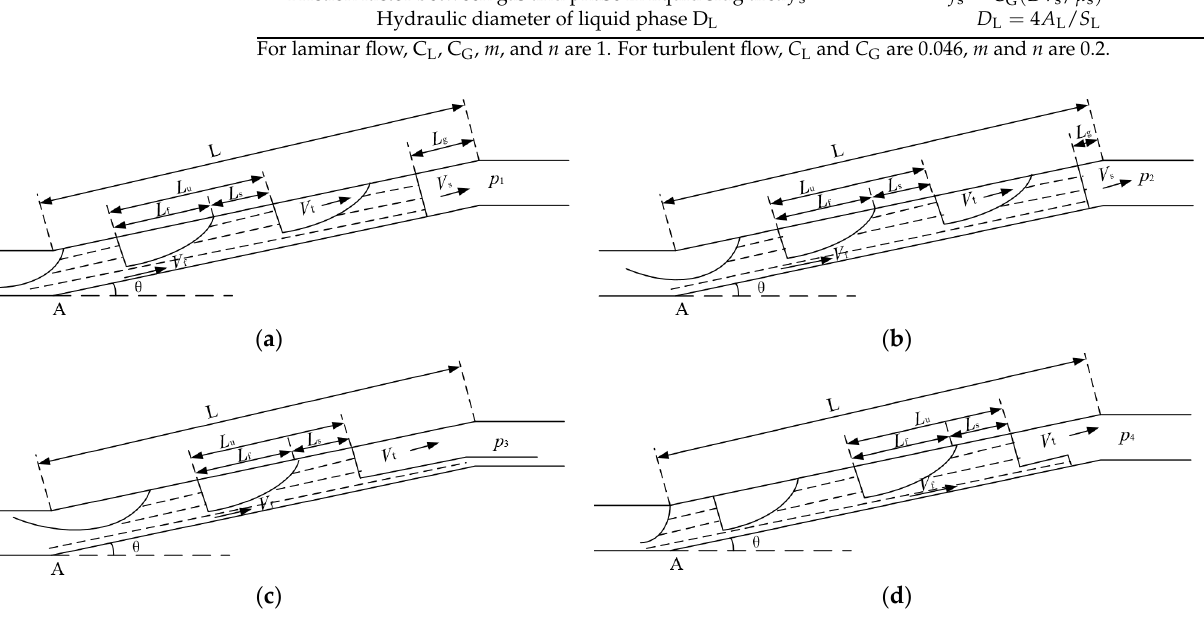
Figure 5. Slug flow pipeline pressure distribution: ( a ) t 1 ; ( b ) t 2 ; ( c ) t 3 ; ( d ) t 4 .